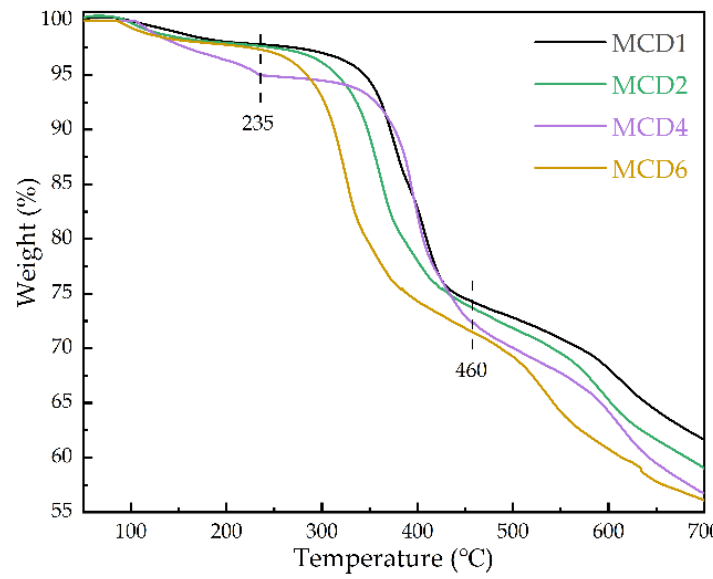
Figure 6. TGA test results of MCDx catalysts.